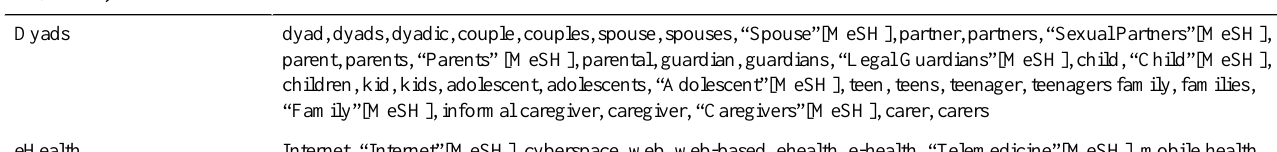
Table 1. Search strategy. with